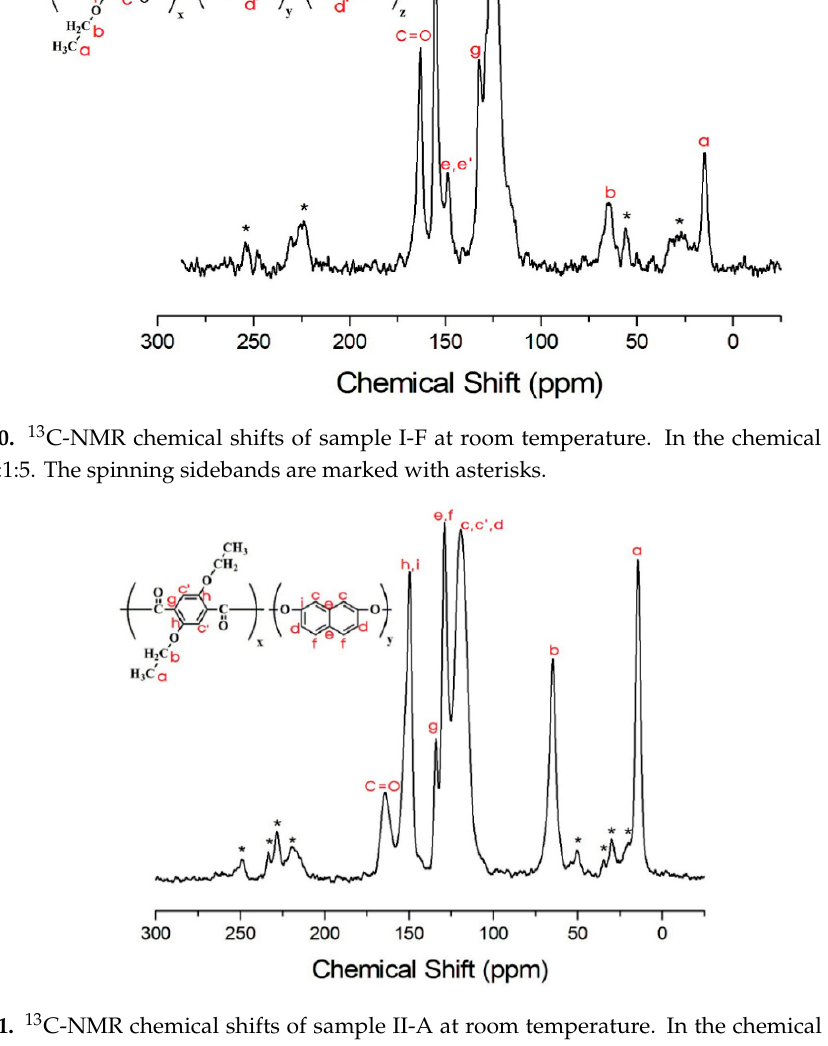
Figure 11. 13 C-NMR chemical shifts of sample II-A at room temperature. In the chemical formula, x:y = 1:1. The spinning sidebands are marked with asterisks.